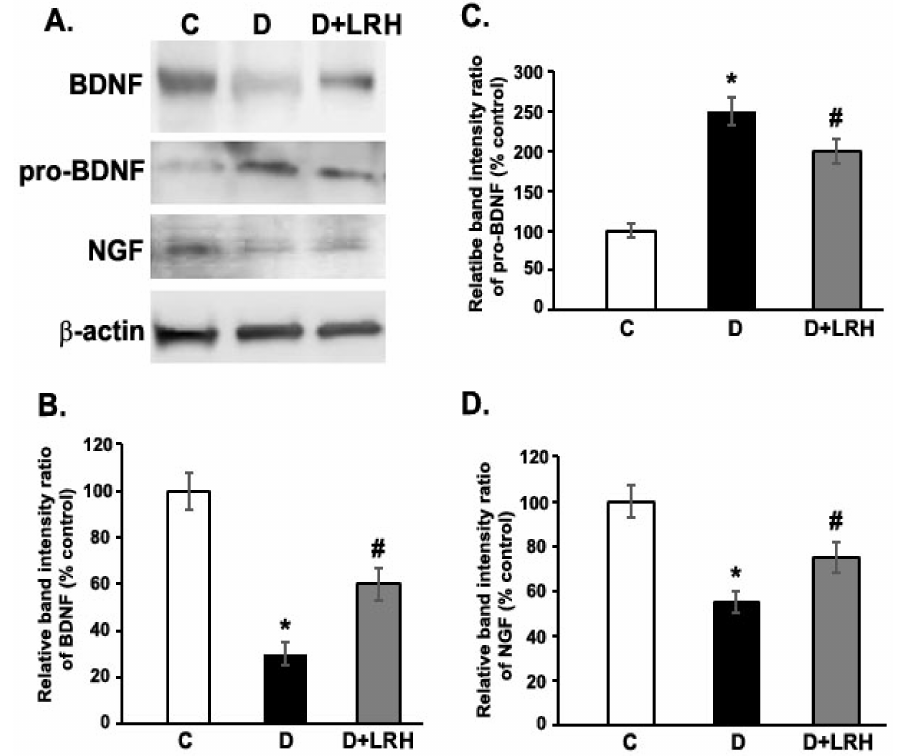
Figure 2. Expression of BDNF, pro-BDNF, and NGF in the high-dose L. regularis (LRH)-treated diabetic rats’ retinas. Densitometry was used to measure the band intensities. Representative bands of the blots of BDNF, pro-BDNF, NGF, and β -actin are shown in Panel ( A ). Band intensity ratios of BDNF protein bands (Panel ( B )), Pro-BDNF protein bands (Panel ( C )), and NGF protein bands are displayed as a percentage of control (Panel ( D )). The values are means ± SEM for six determinations. * p < 0.01, suggests a significant difference from their controls; # p < 0.05 suggests a significant difference from diabetic retinas. Experiments with immunoblotting were conducted